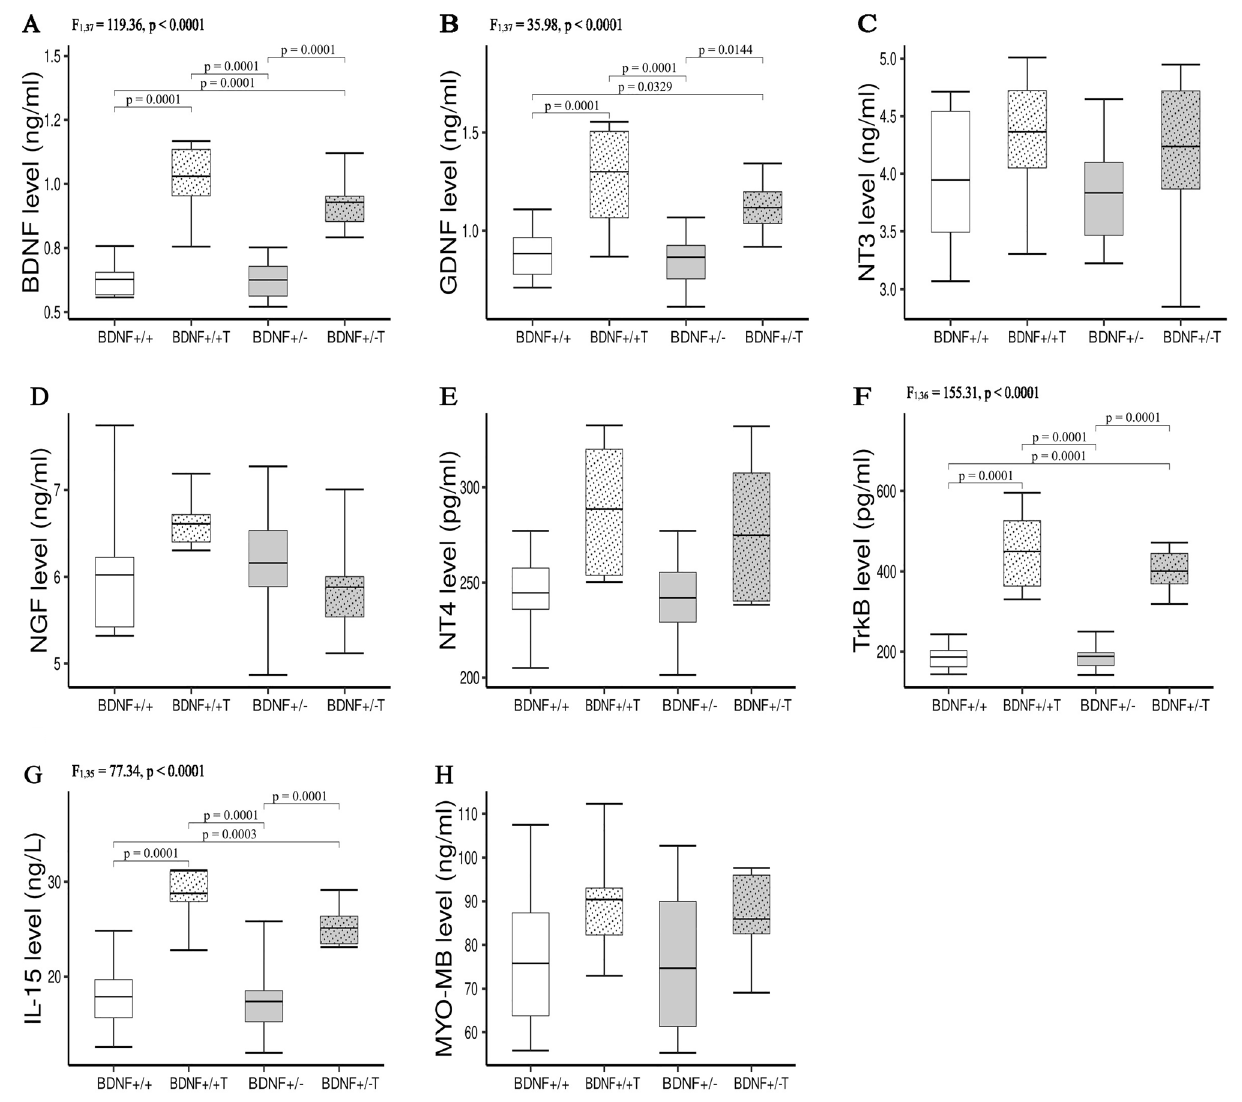
Figure 3. The concentrations of BDNF ( A ), GDNF ( B ), NT3 ( C ), NGF ( D ), NT4 ( E ), TrkB ( F ), IL-15 ( G ), MYO-MB ( H ) in medial gastrocnemius muscles of Bdnf +/+, Bdnf +/+ T, Bdnf +/−, and Bdnf +/− T rats. The bars indicate the mean values, box-plots ± 25% of the dataset, and whiskers ± SD. Differences between the Bdnf +/+ and Bdnf +/− animals, as well as between the Bdnf +/+ T and Bdnf +/− T groups are indicated above the plots (two-way ANOVA with genotype and training as fixed factors with Tukey’s HSD post-hoc